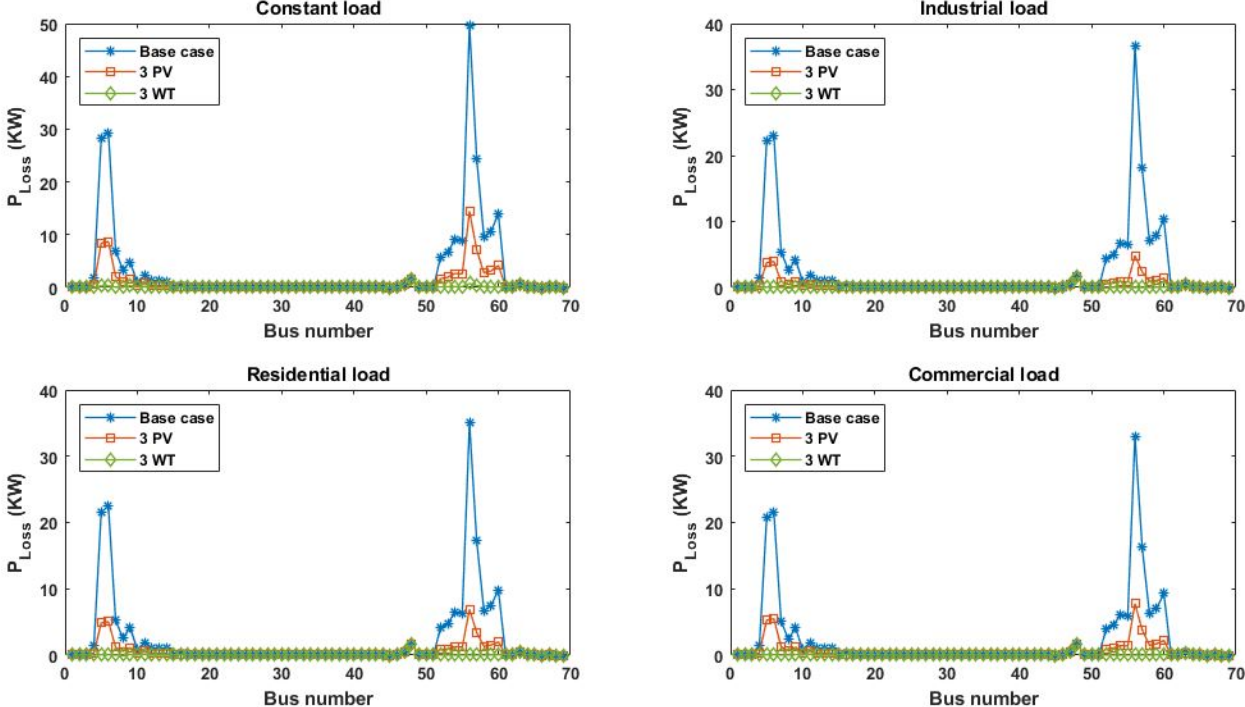
Figure 9. Active power loss for 69 buses under various types of loads for scenario 1.